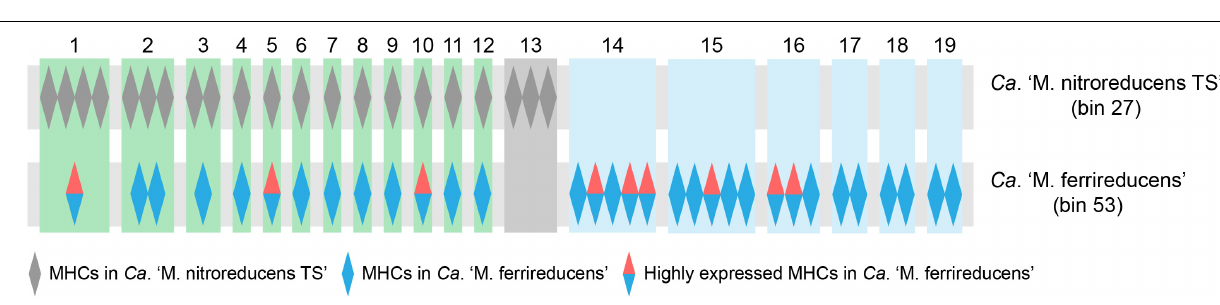
FIGURE 5 | Rooted maximum-likelihood phylogenomic tree with draft genomes recovered in this study highlighted in blue. Bootstrap support between 95 and 100% were indicated as black circles.